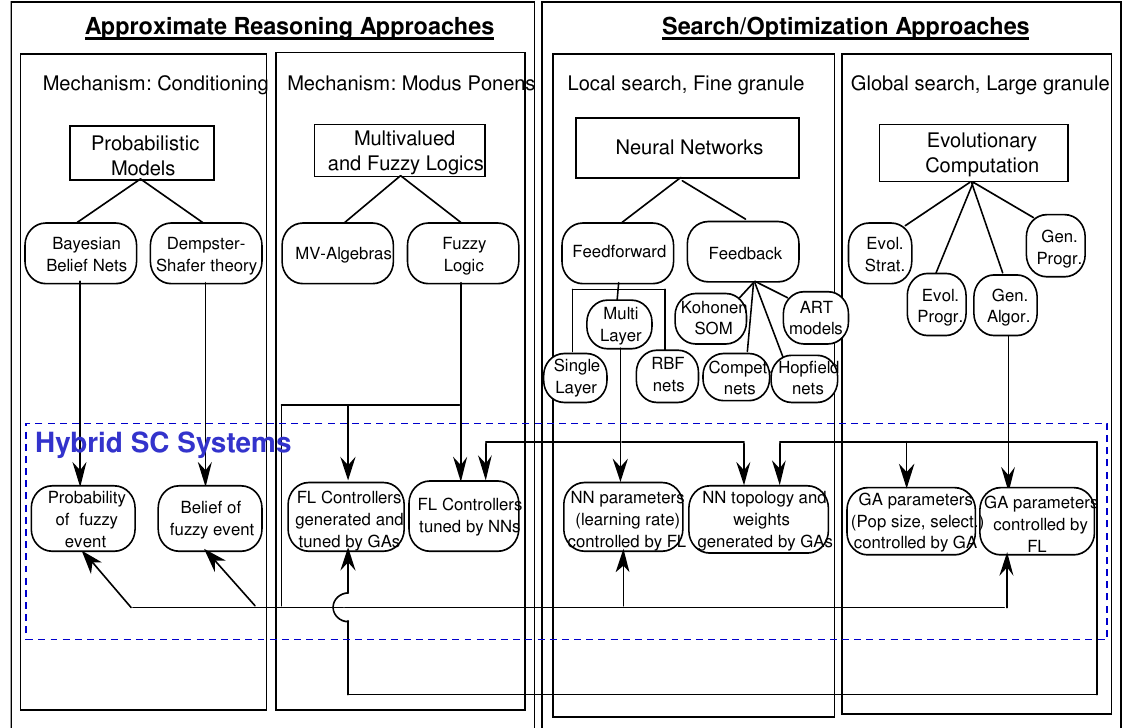
Fig. 1. Soft Computing Overview (adapted from reference